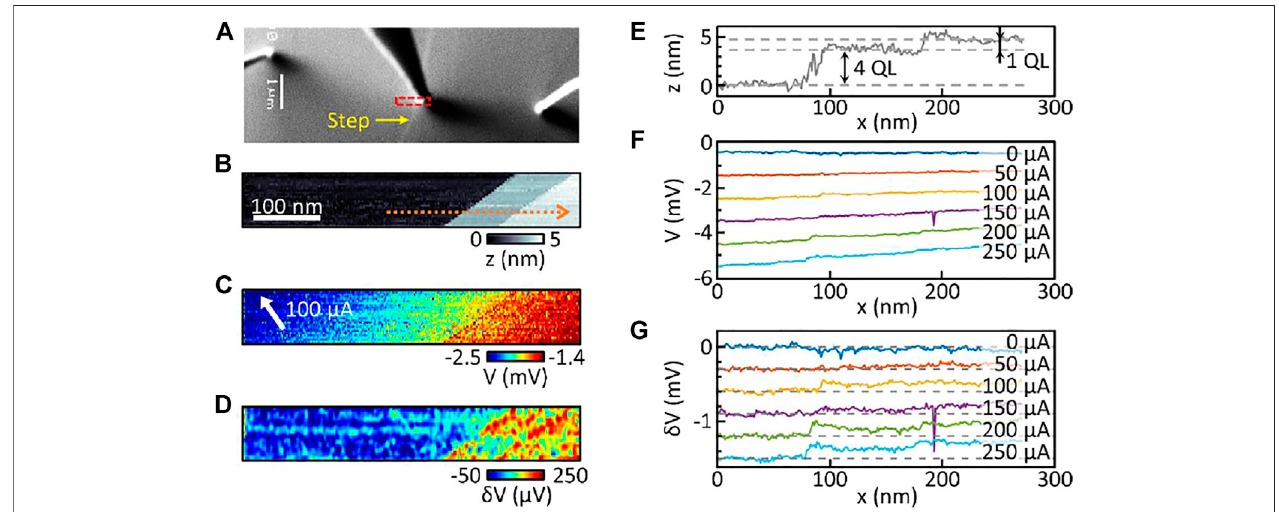
FIGURE 3 | (A) SEM image of the surface with steps and three probes in STP con fi guration. The red box denotes the area where STP measurements were taken. (B) Topographicimageofthearea, (C) RawSTPmap, and (D) STPmapwiththeoverallslopesubtractionand lowpass fi lteringforenhanced contrastacrossthesteps. Line pro fi le data of (E) height, (F) potential, and (G) potential with the slope subtracted plotted, which are taken along the orange dotted line in (B) .